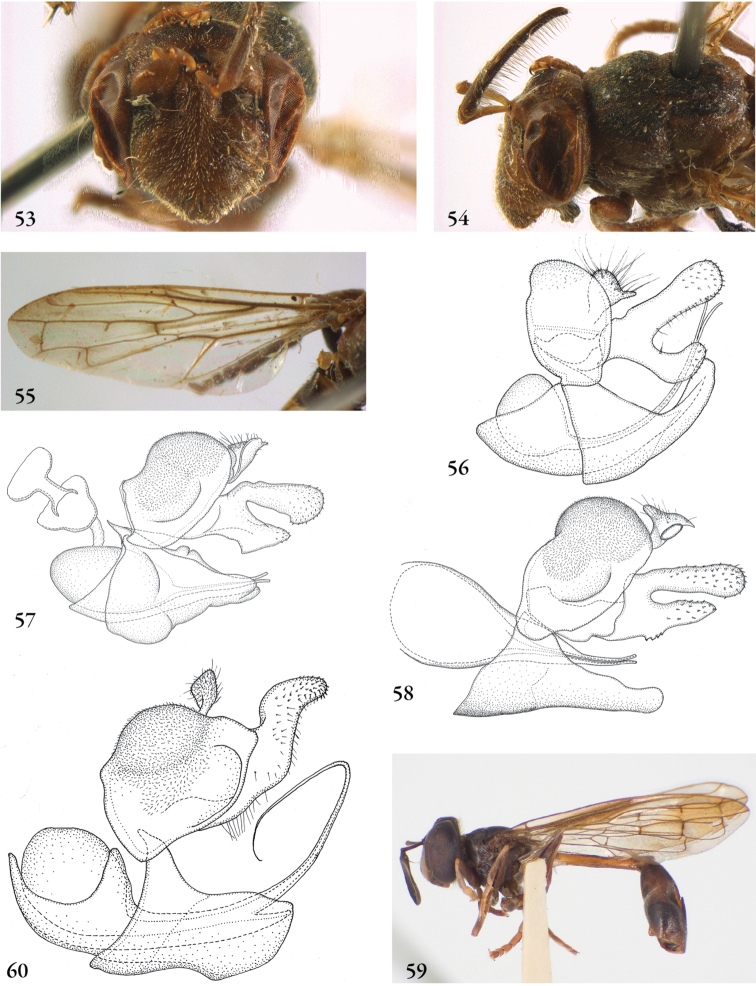
53–55
Ceratrichomyia angolensis male (holotype): 53 head frontal 54 head lateral 55 wing. 56–58
Ceratrichomyia males (holotypes): 56
Ceratrichomyia angolensis
57
Ceratrichomyia behara
58
Ceratrichomyia bullabucca
59–60
Ceriomicrodon petiolatus male (holotype): 59 habitus lateral 60 genitalia lateral.